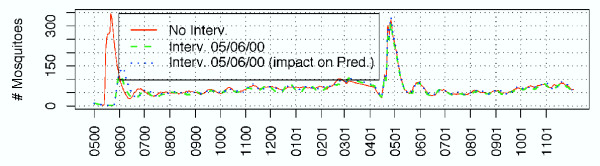
An. gambiae adult abundance with larval control intervention and predators